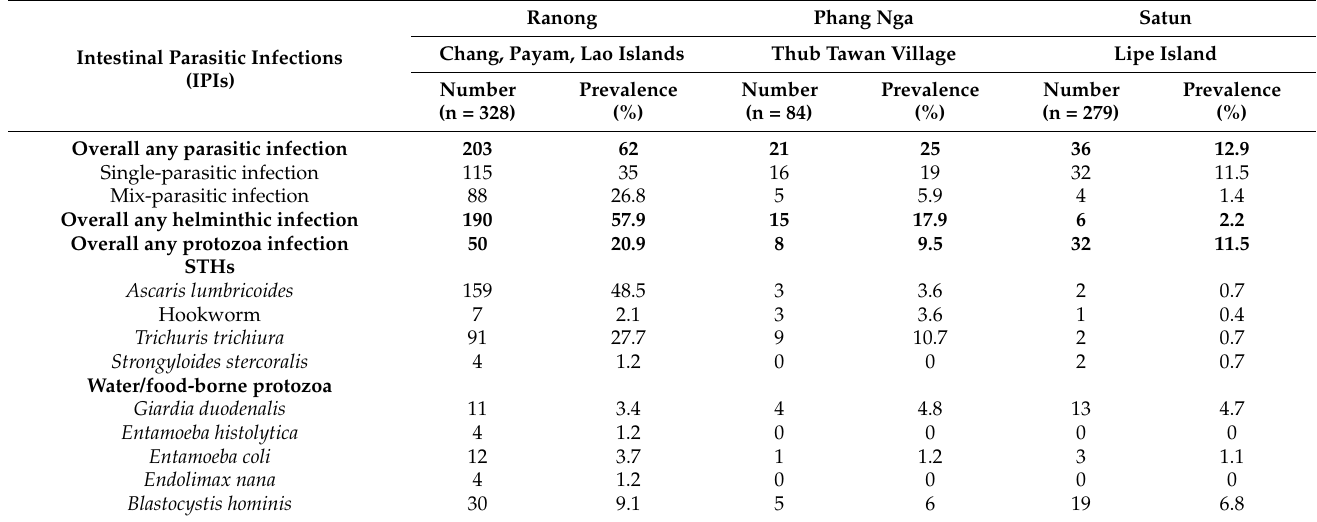
Table 2. Prevalence, types, and species of parasitic infection (helminths and protozoa) found in Moken and Orang Laut living in three provinces in